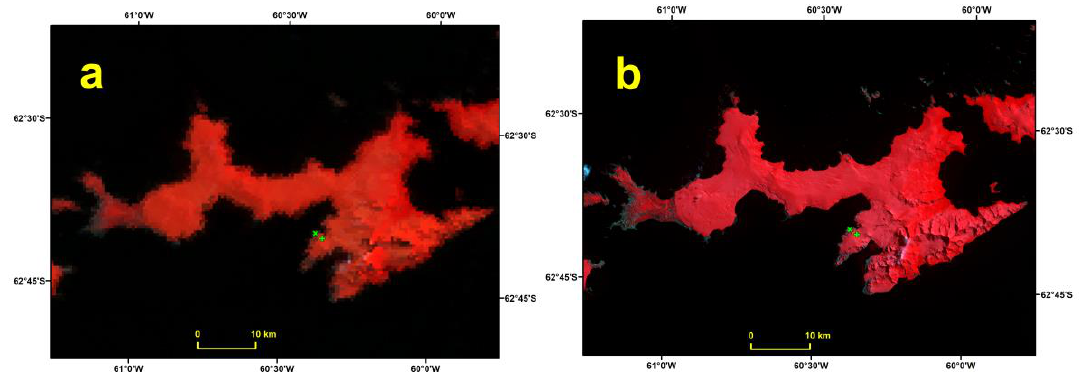
Figure 4. RGB composites of MOD09GA ( a ) and Landsat 8 ( b ) of Livingston Island of January 16 2014. Images are projected in WGS-84 UTM20S. The location of the Automatic Weather Stations at Juan Carlos I and Johnsons Glacier are indicated with a green cross and a green plus sign, respectively.